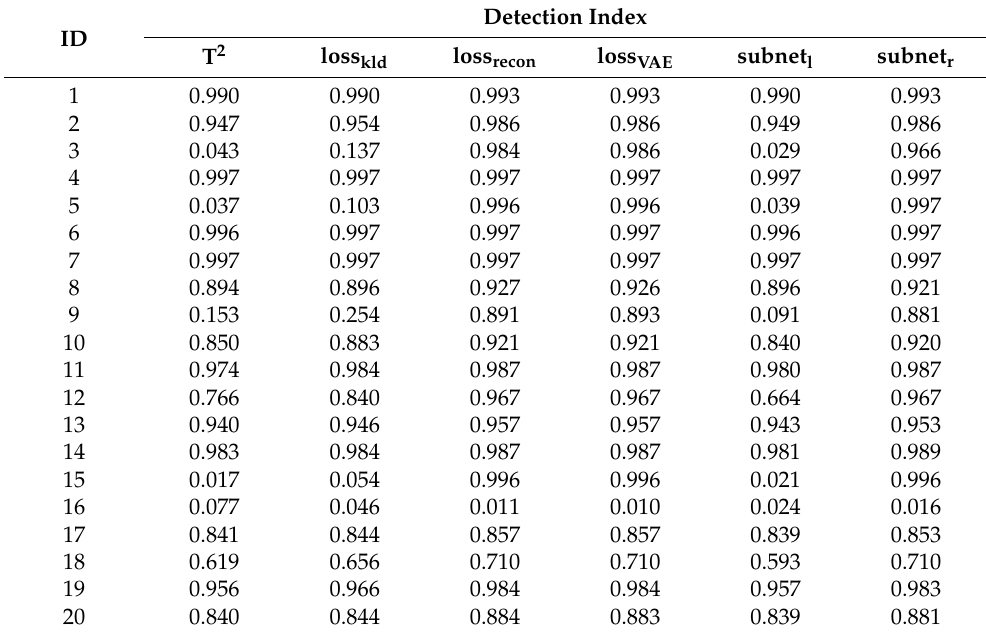
Table 4. Fault detection by Dynamic